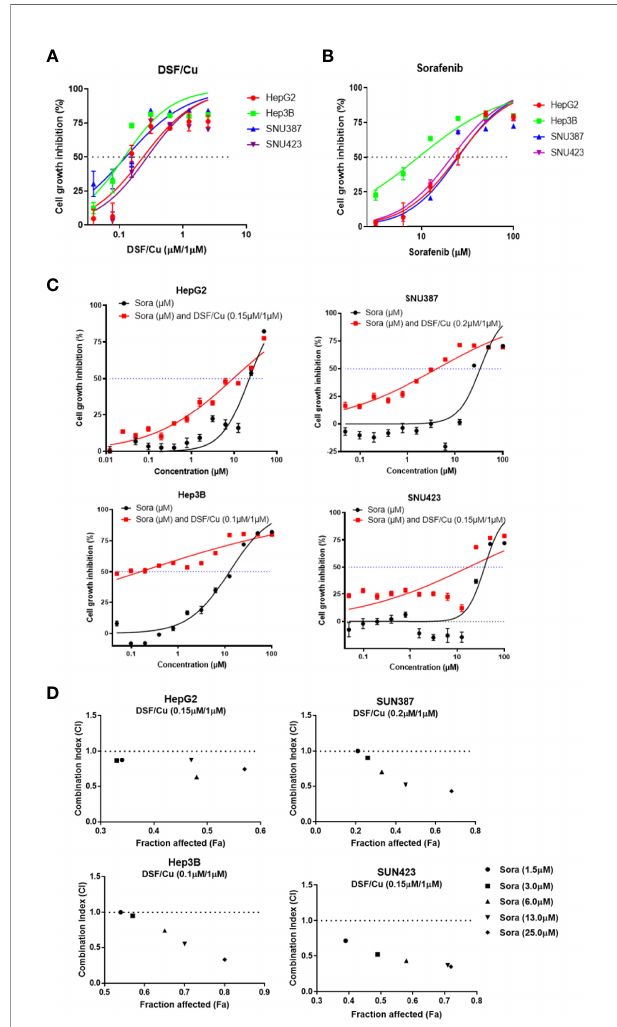
FIGURE 1 | DSF/Cu and sorafenib (or Sora) synergistically inhibit the growth of HCC cells in vitro . The HCC cell lines HepG2, Hep3B, SNU387, and SNU423 were treated with DSF/Cu or sorafenib at different concentrations for 48 h followed by MTT assay to evaluate their cell growth inhibition rate (A, B) . Cells were treated with a fi xed concentration of DSF/Cu [HepG2 (0.15 m M/1 m M), Hep3B (0.10 m M/1 m M), SNU387 (0.20 m M/1 m M), and SNU423 (0.15 m M/1 m M)] and different concentrations of sorafenib for 48 h. Cell growth inhibition was determined by MTT assay (C) . CI values were calculated using CompuSyn software and graphed for each cell line (D) . CI<1, = 1, and >1 indicated synergistic, additive, and antagonistic effects, respectively. IC 50 , half-maximal inhibitory concentration. All experiments were performed in triplicate for each cell